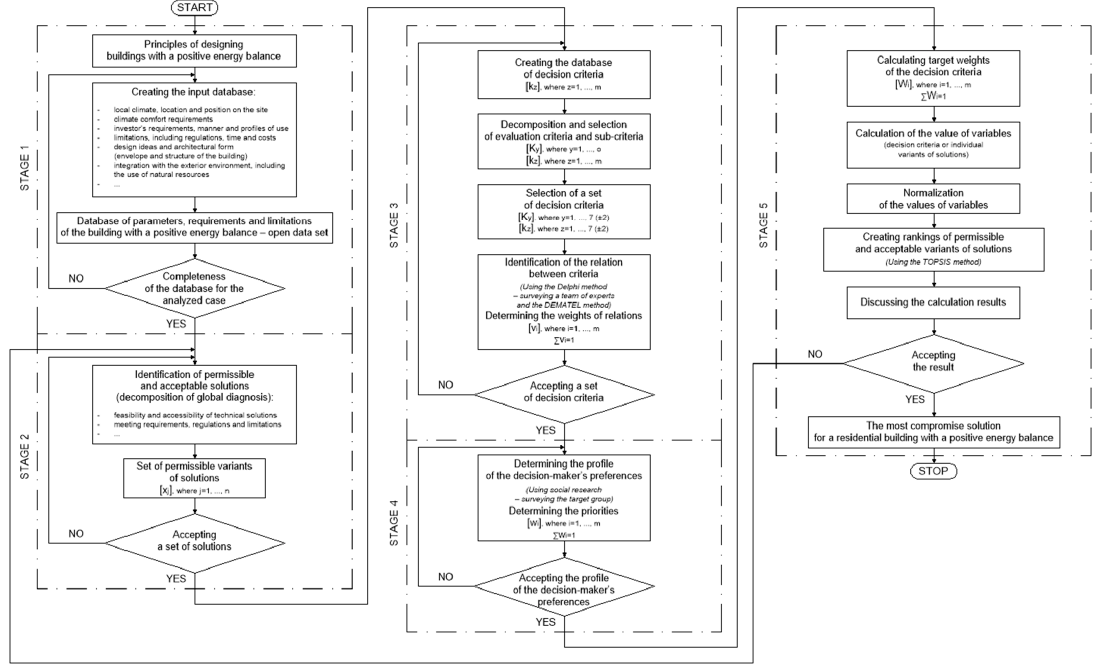
Figure 1. Methodology for designing a residential building with a positive energy balance.